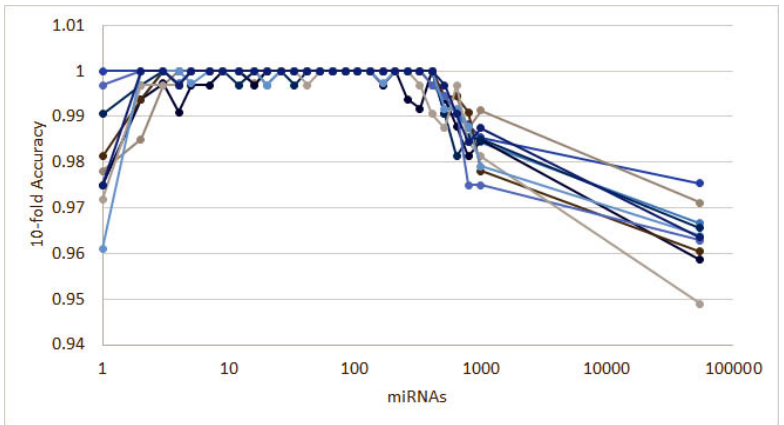
Figure A4. Ten runs of the heterogeneous ensemble recursive selection algorithm: From the 10 runs, the highest accuracy is given by MUC4 gene expression alone.